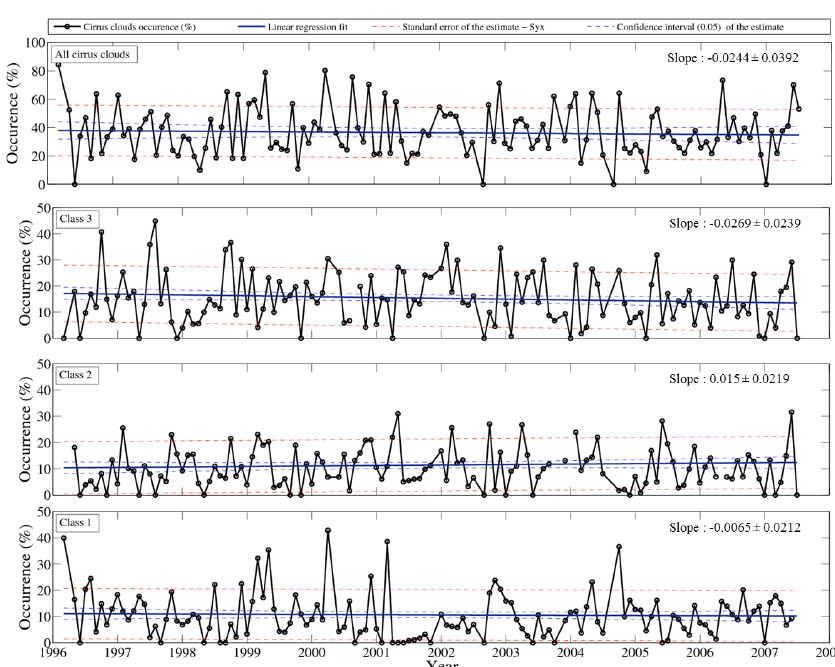
Fig. 14. Evolution of cirrus clouds occurrence from the OHP lidar. The black line with dots represents the cirrus clouds occurrence considering all cirrus clouds (top row) and each class (indicated at the top left corner of panel). The blue line represents the linear trend calculated over the entire time series (see Sect. 5.1 for details). Dashed blue lines represent the confidence interval (0.9) of the estimate and the dashed red lines the standard error of the estimate.